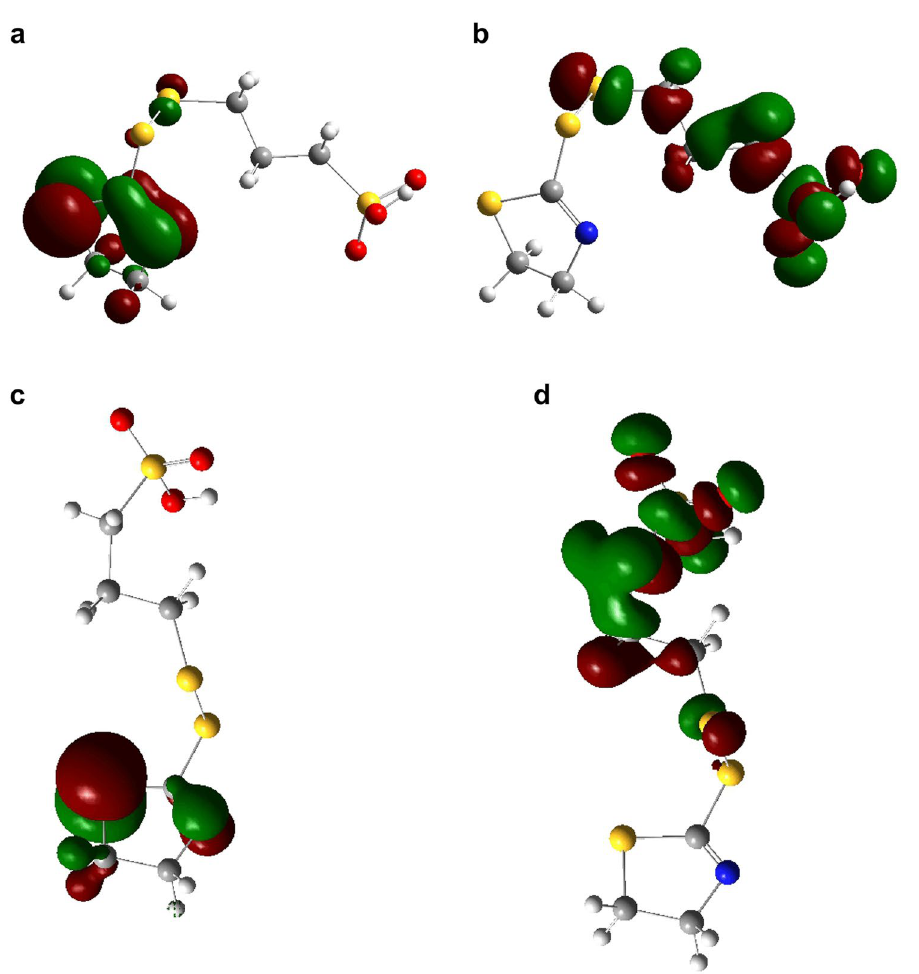
Figure 9. Geometry of SH110. ( a ) Initial HOMO, ( b ) initial LUMO, ( c ) equilibrium HOMO, and ( d ) equilibrium LUMO ( https:// www. 3ds. com/ produ cts- servi ces/ biovia/ material studio